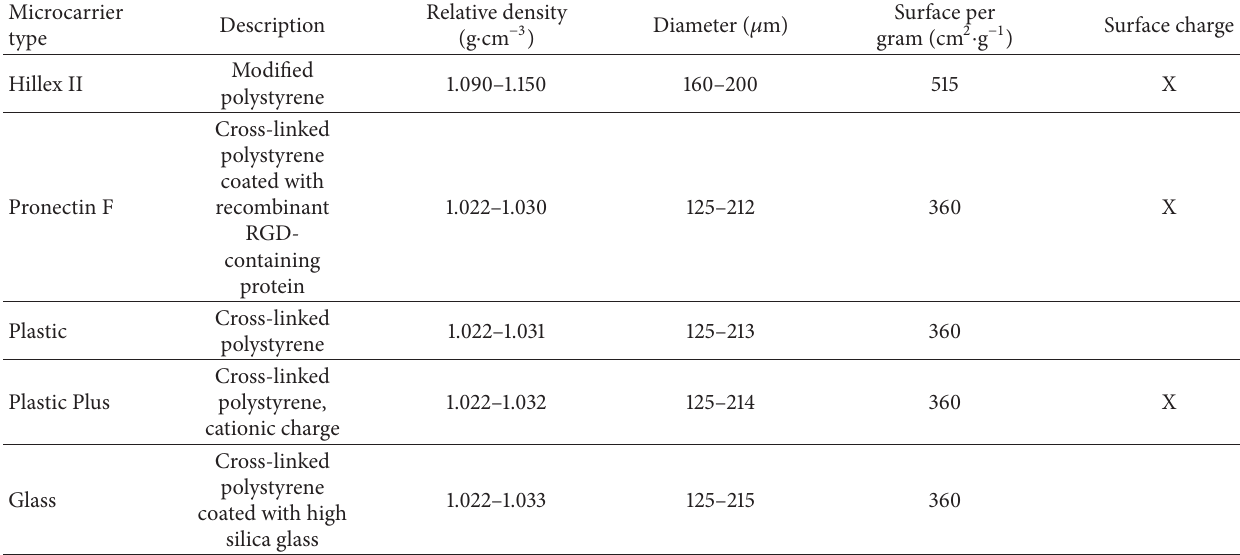
Table 1: Microcarrier specification for Animal Product-Free Starter Kit by SoloHill, Pall